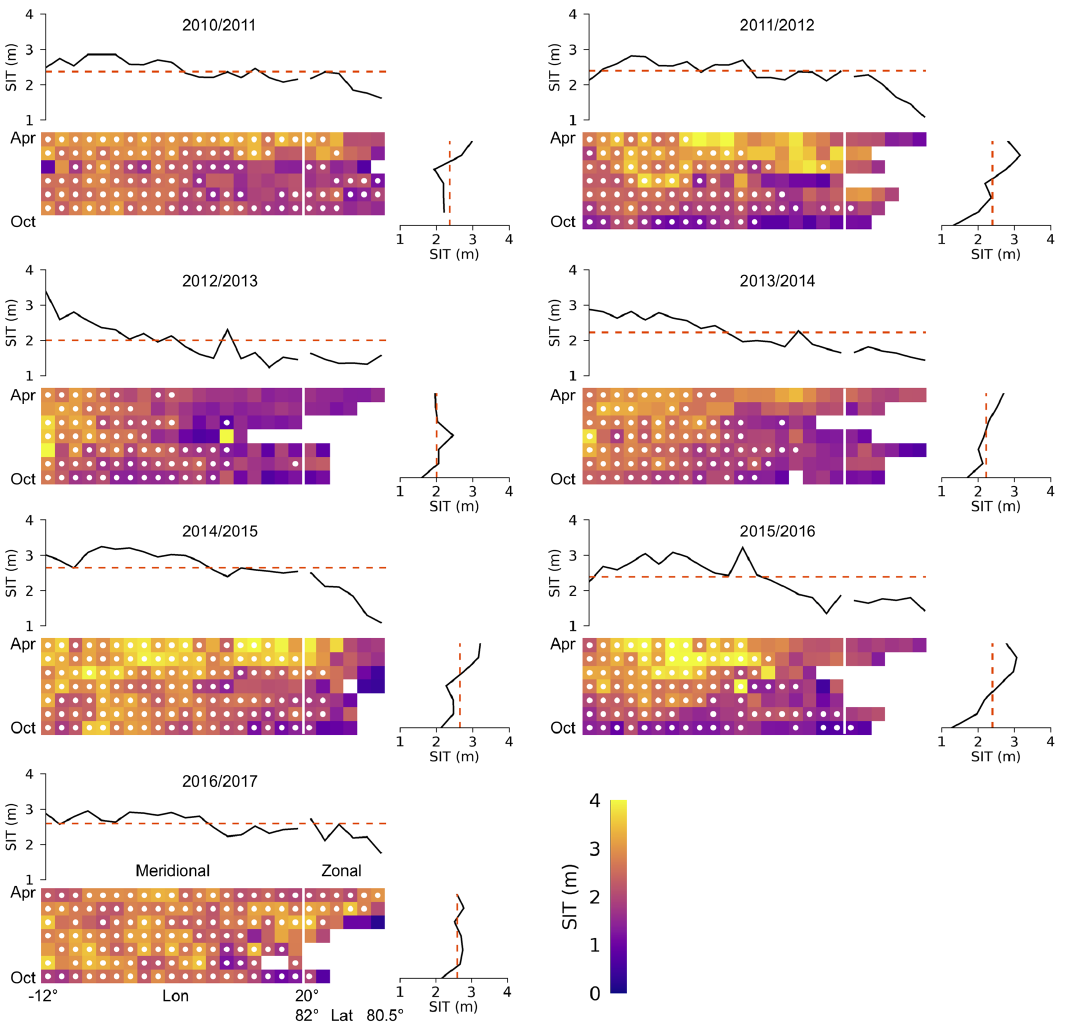
Figure 2. Spatio-temporal variability in sea ice thickness (SIT) at the Fram Strait gate from October to April between 2010 and 2017. Upper sub-panels show the temporally averaged SIT. Right sub-panels show the average over the gate SIT for each month within the October–April period. The white dots represent grid cells that contain multi-year